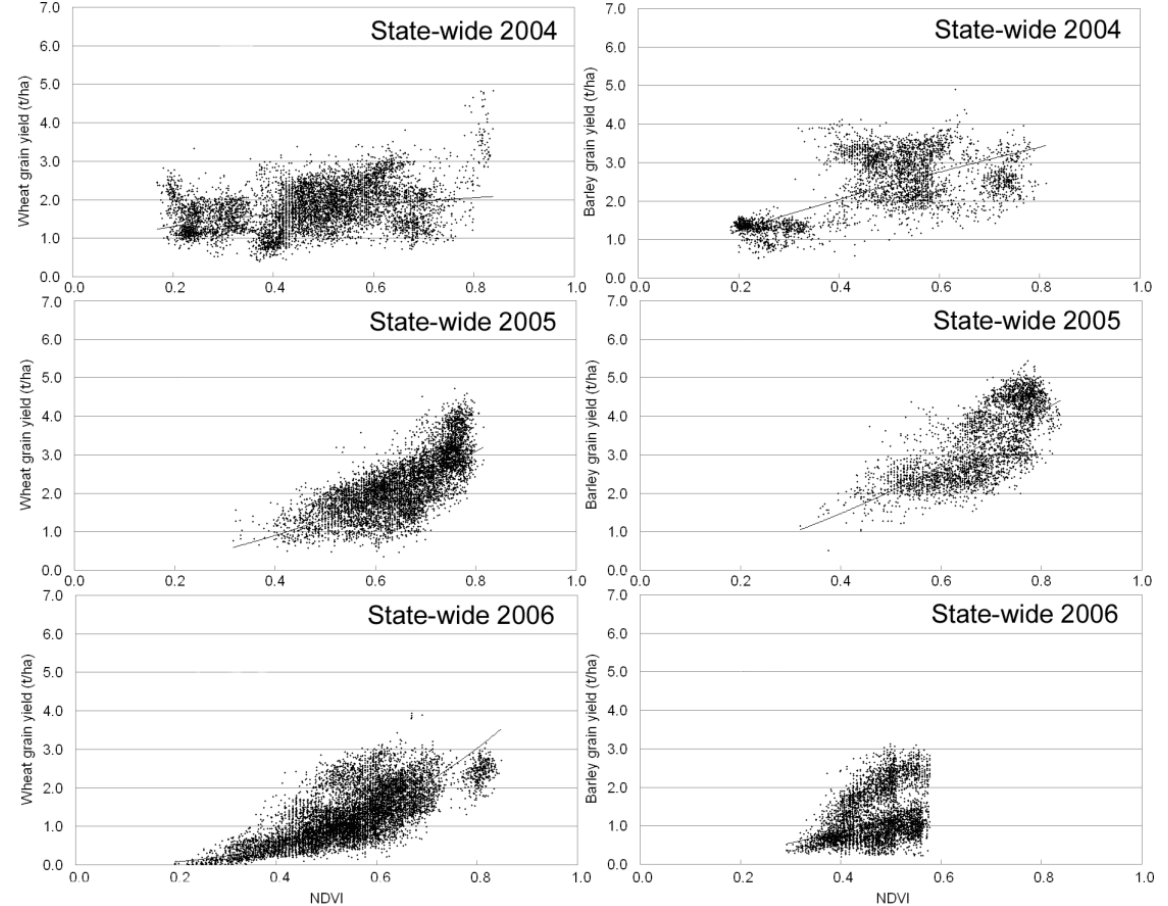
Figure 3. Wheat and barley yield vs. NDVI scatter graphs and fitted empirical power models for the state-wide analysis for 2004, 2005 and 2006. Table 3. Power empirical relationships, R2 and efficiency criteria (root mean square error (RMSE), % of RMSE of average yield and the Nash–Sutcliffe Efficiency Criterion ( E )) for the annual wheat and barley and the 2005 model for the state-wide analysis in 2004, 2005 and